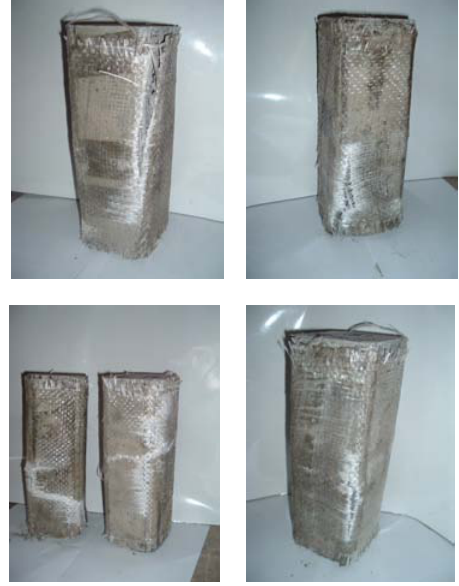
Fig. 8. Failure modes of columns and GFRP torn at the level of